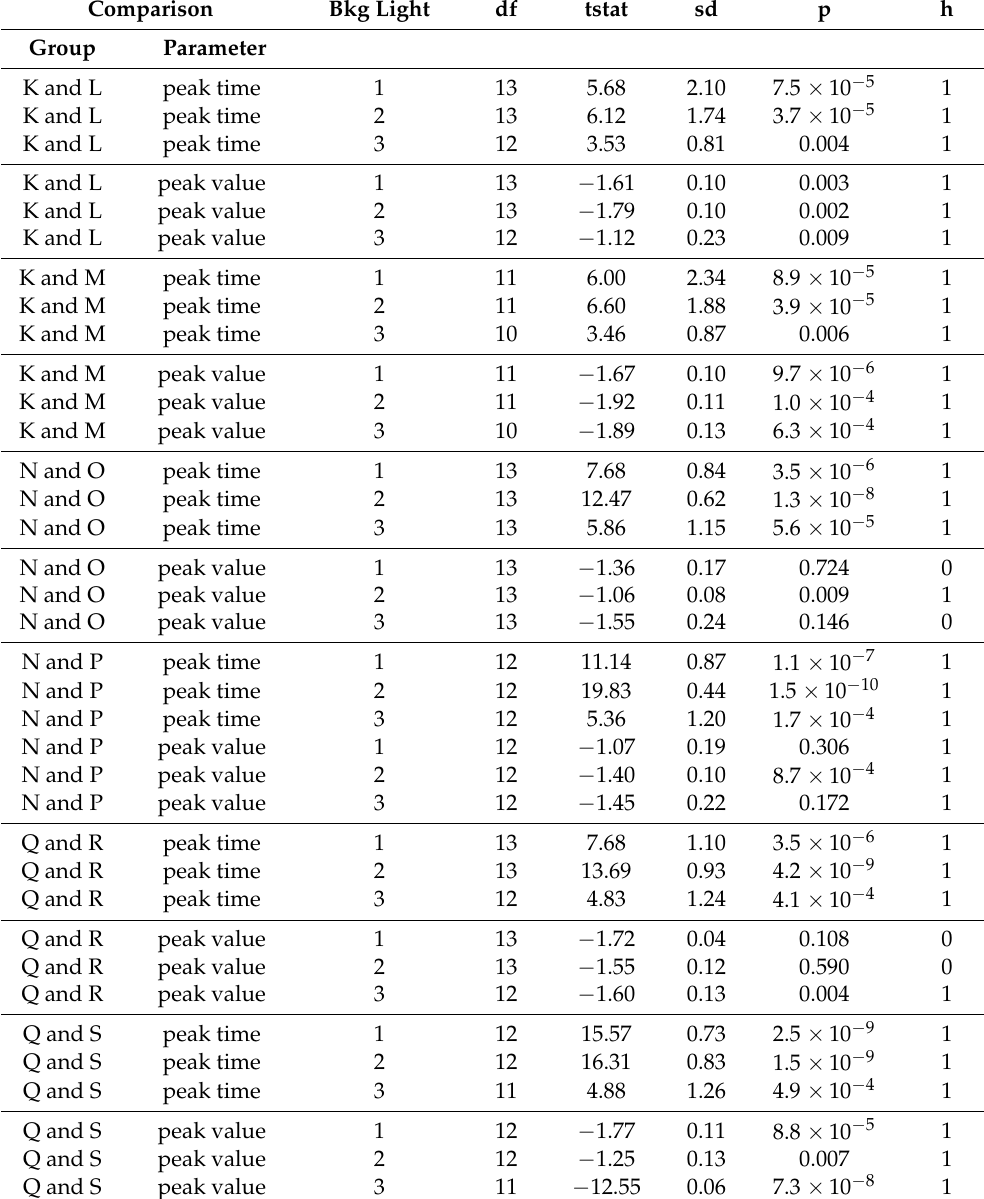
Table A3. Two way ANOVA table, comparing the peak times and peak values for weeks (w) 1, 2, and 3, for plant in the Pythium ultimum setup. Plants are divided into groups independent of being infected or not. Stress is detected over time, and the authors believe that heat stress is detected. K: tomato, week 1 (w 1), L: tomato, w 2, M: tomato, w 3. N: basil, w 1, O: basil, w 2, P: basil, w